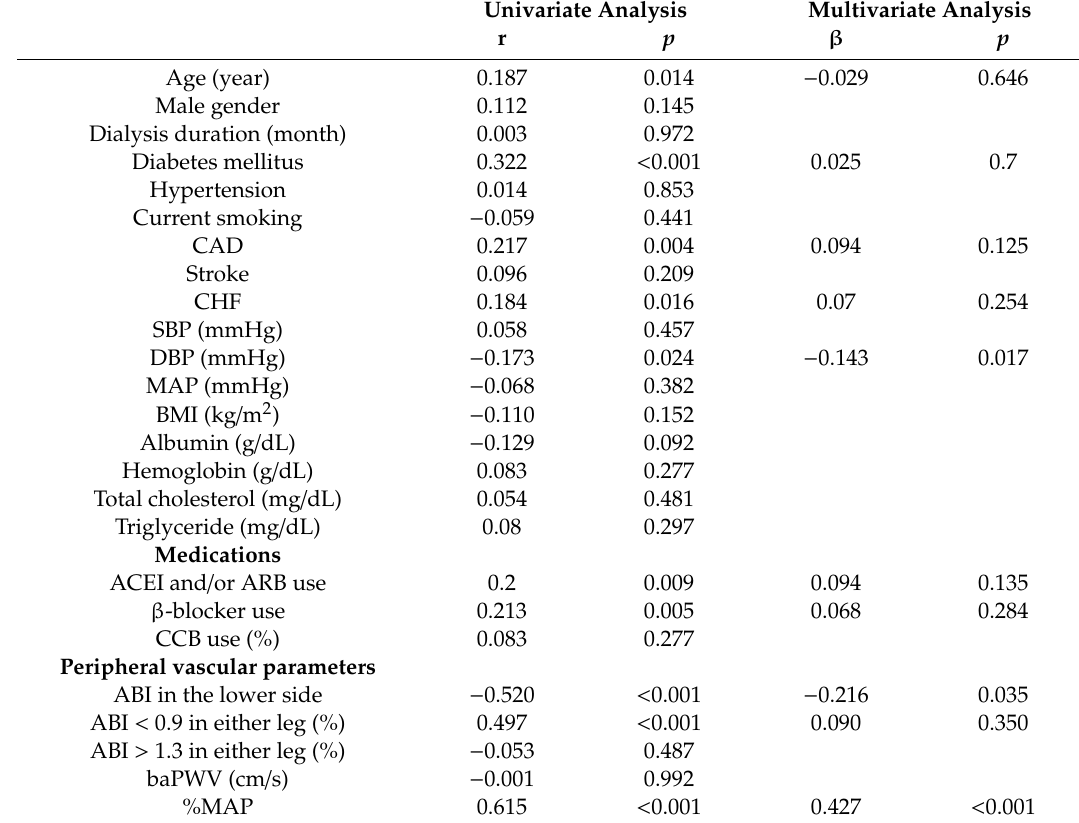
Table 3. Univariate and multivariate correlates of UT in study